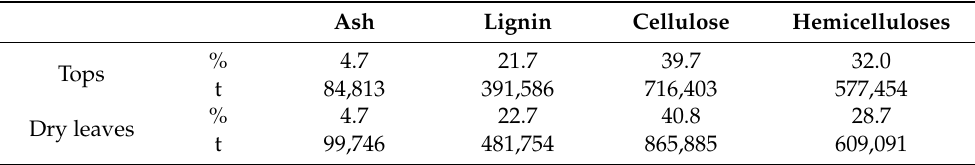
Table 6. Composition of trash in regard to lignocellulosic materials and ash content.